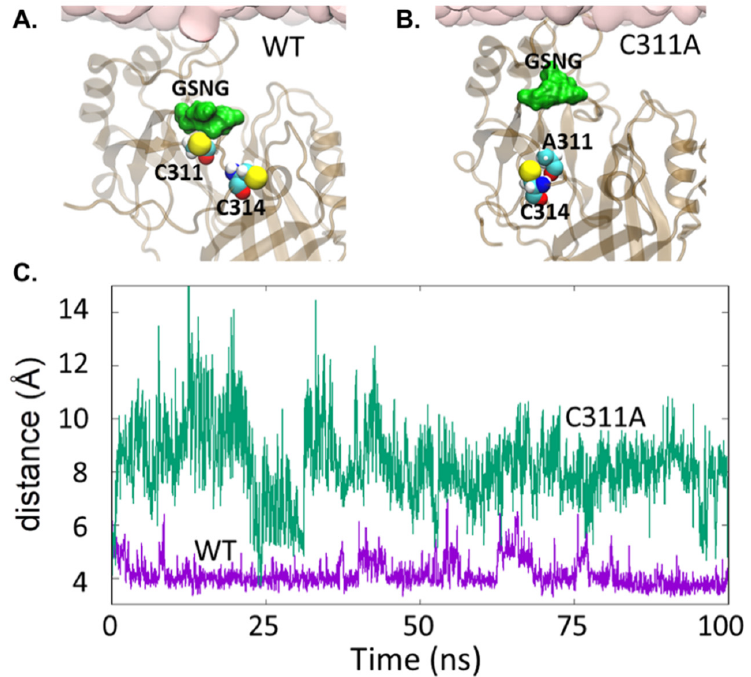
Figure 8. Molecular dynamics simulations demonstrate Cys 311 restrains a CTD motif, whereas C311A enhances the CTD motif flexibility and C311A membrane binding. ( A ) Cys 311 interacting with the two polar residues (Ser 199 , Asn 200 ) in the GSNG motif. ( B ) C311A mutation enhances the flexibility of the GSNG motif, which underlies the CTD lipid binding surface of VP40. ( C ) Distance between the C α atoms of residues 201 and 311 (purple: WT, green: C311A).